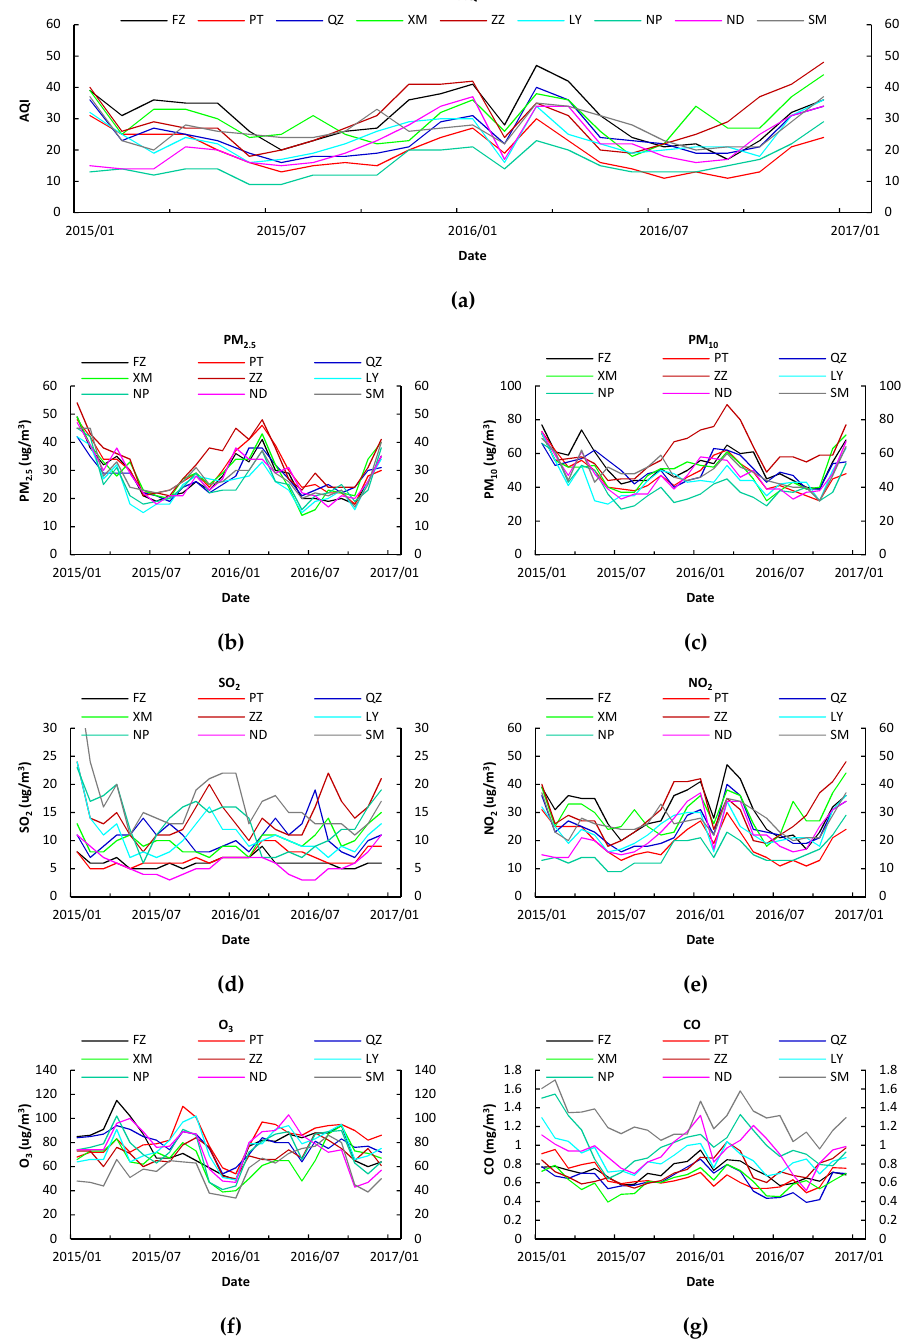
Figure 4. Temporal variation of the concentrations of six criteria air pollutants in the 37 stations in all 9 cities of Fujian province. ( a ) AQI, ( b ) PM 2.5 , ( c ) PM 10 , ( d ) SO 2 , ( e ) NO 2 , ( f ) O 3 and ( g ) CO.